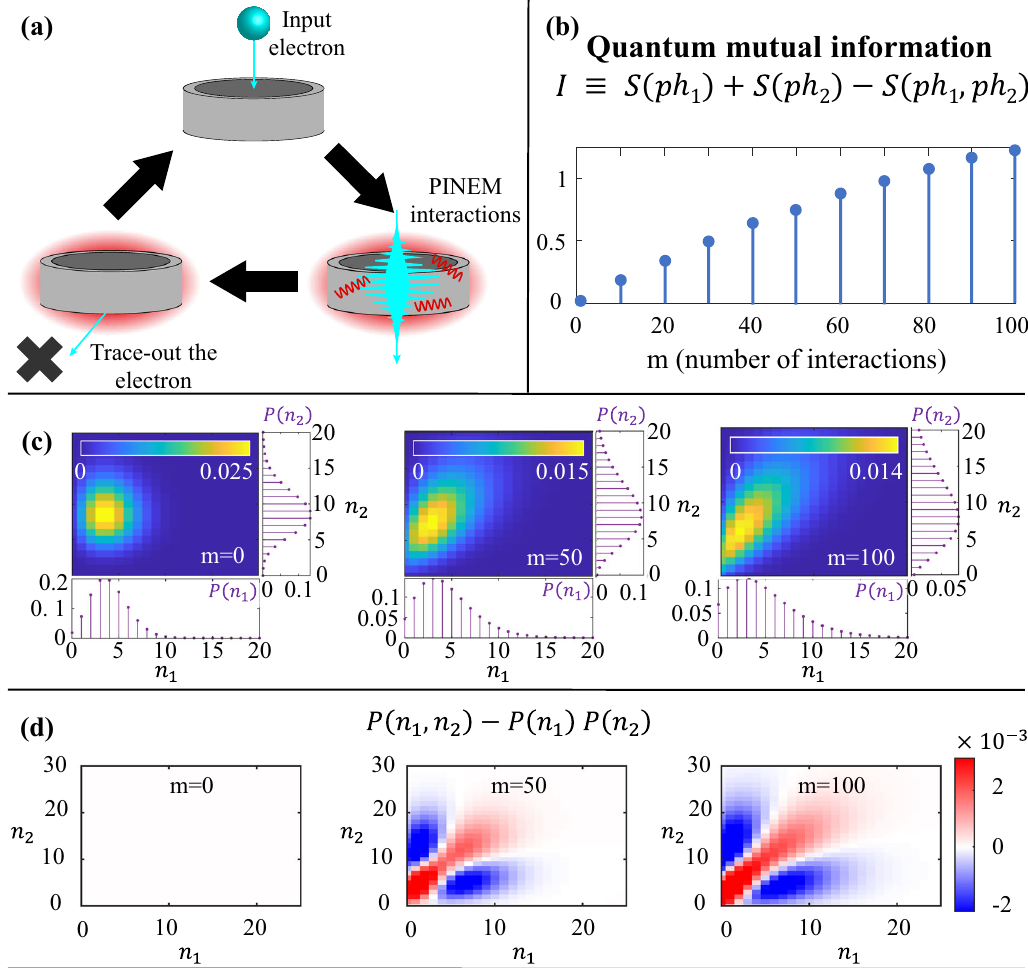
Fig. 2 Correlations induced between two photonic states after interacting with free electrons. a Interaction scheme. After each interaction of an electron and the two photonic states, we trace out the electron. In certain cases, we then input another electron into the system and repeat. b The quantum mutual information as a function of the number of interactions increases with the number of interactions, indicating that correlations are induced. c Statistic of two coherent states with α 1 = 2 and α 2 = 3 after m = 0, 50, 100 consecutive interactions with